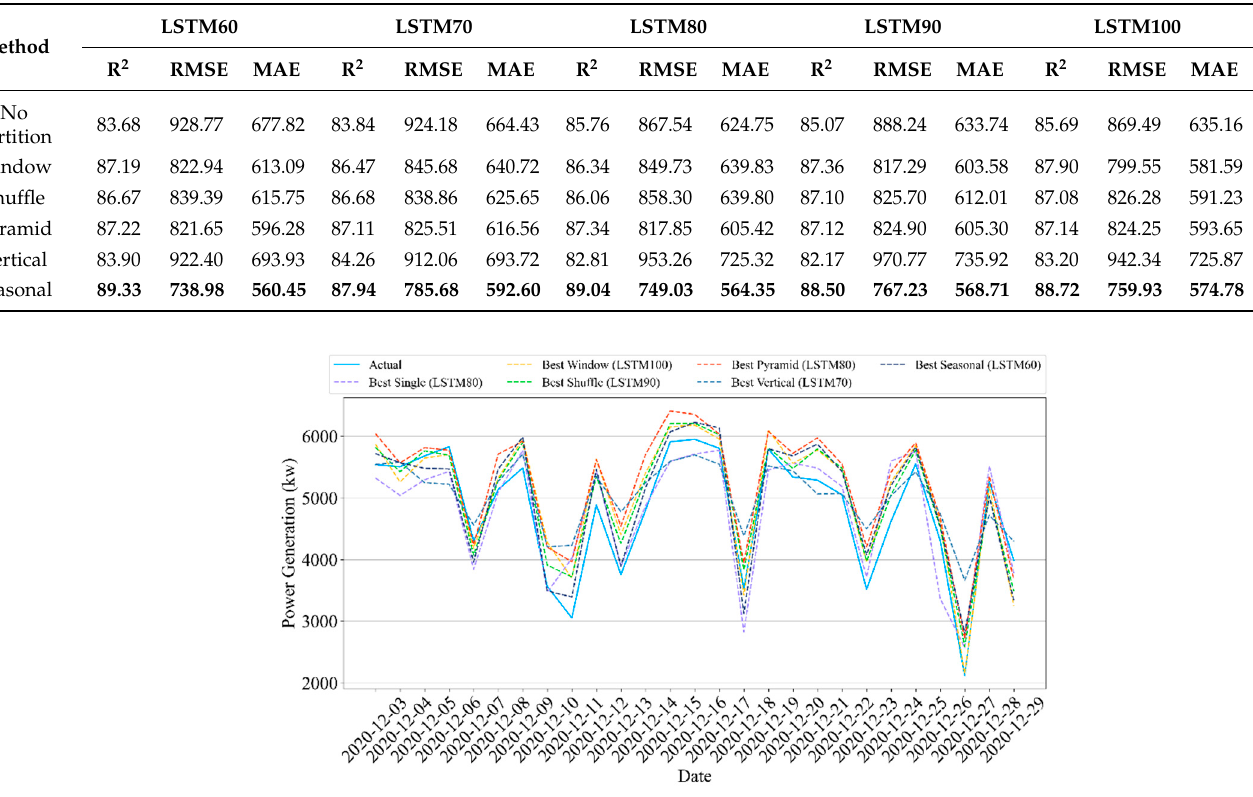
Figure 9. Results of daily forecasting of Site B.